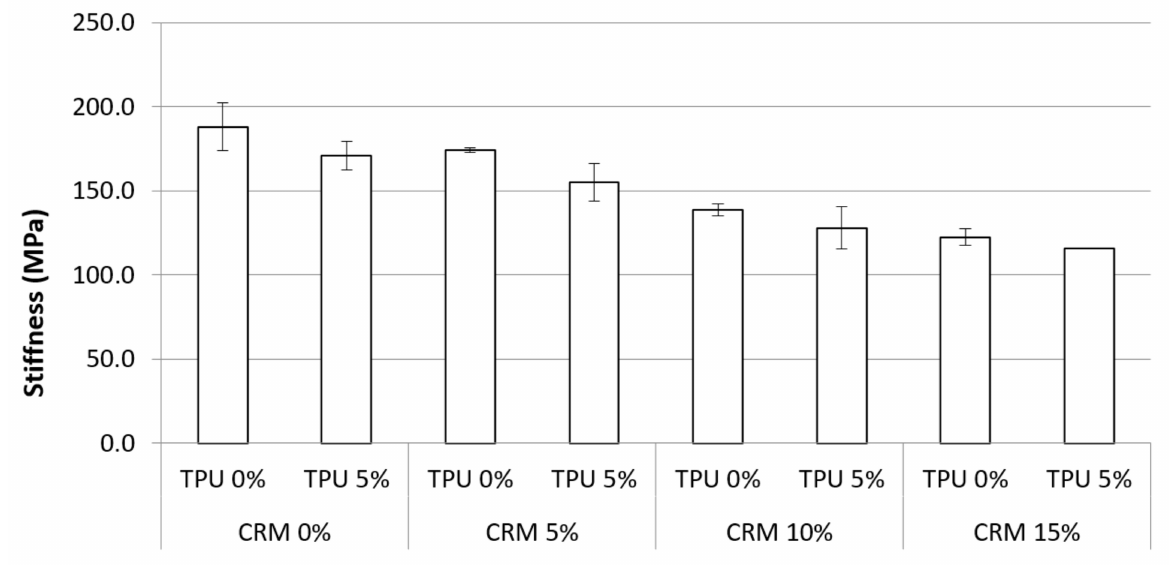
Figure 11. The stiffness of the asphalt binders containing CRM and TPU for RTFO + PAV condition. The statistical significance of the difference in the stiffness was evaluated as shown in Table 10. In terms of stiffness, increasing CRM contents revealed a significant difference in all binders, whereas using the TPU in CRM binders shows a non-significant difference. However, a non-significant difference was witnessed between CRM 5% and CRM 0% + TPU 5%, which means that even though the CRM is applied less with 5%, there is no statistical difference between them due to the effect on decreasing stiffness by using the TPU. Table 10. Statistical analysis results of the stiffness as a function of CRM contents and the addition of TPU ( α =